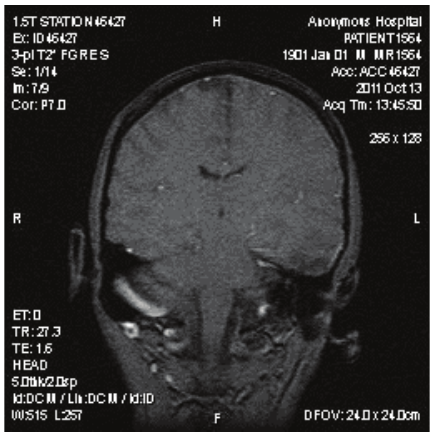
Figure 1: Brain MRI with and without contrast showing bihemi- spheric subdural hematomas.